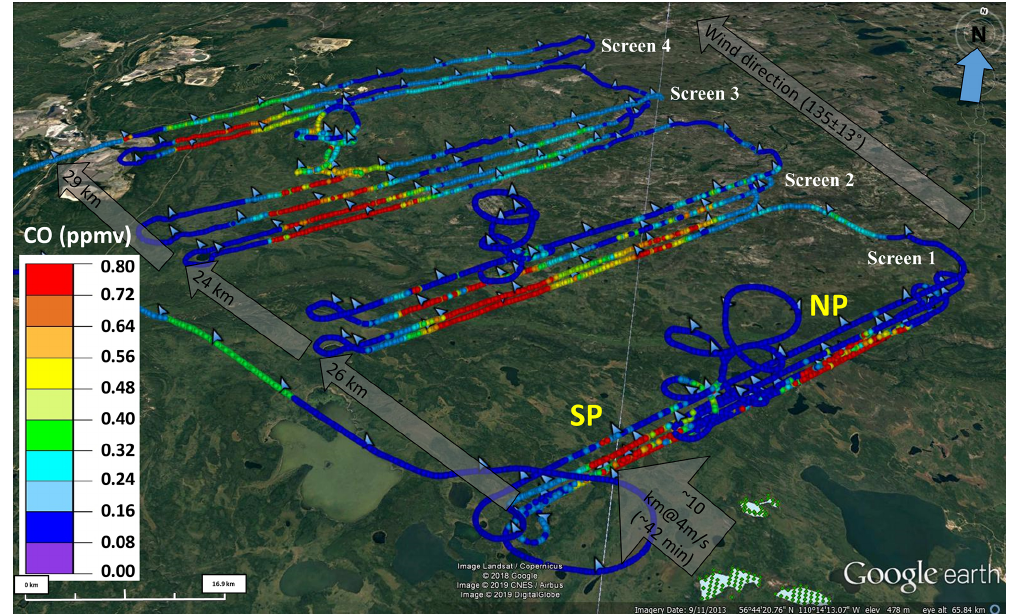
Figure 2. Flight tracks coloured by CO mixing ratio (ppmv) for screens 1 to 4. The two plumes are identified as south plume (SP) and north plume (NP). The fire perimeter surrounding the detected MODIS-derived “hot spots” on 25 June 2018 is shown in the green hatched area. The source of the NP is expected to be the same hot spots as the SP but ∼ 30min older; see Sect. 2.2. The small blue arrows along the flight tracks indicate the aircraft-measured wind direction with the average wind direction depicted with the large grey arrow. Distances between screens are shown in the grey arrows. © Google Earth.